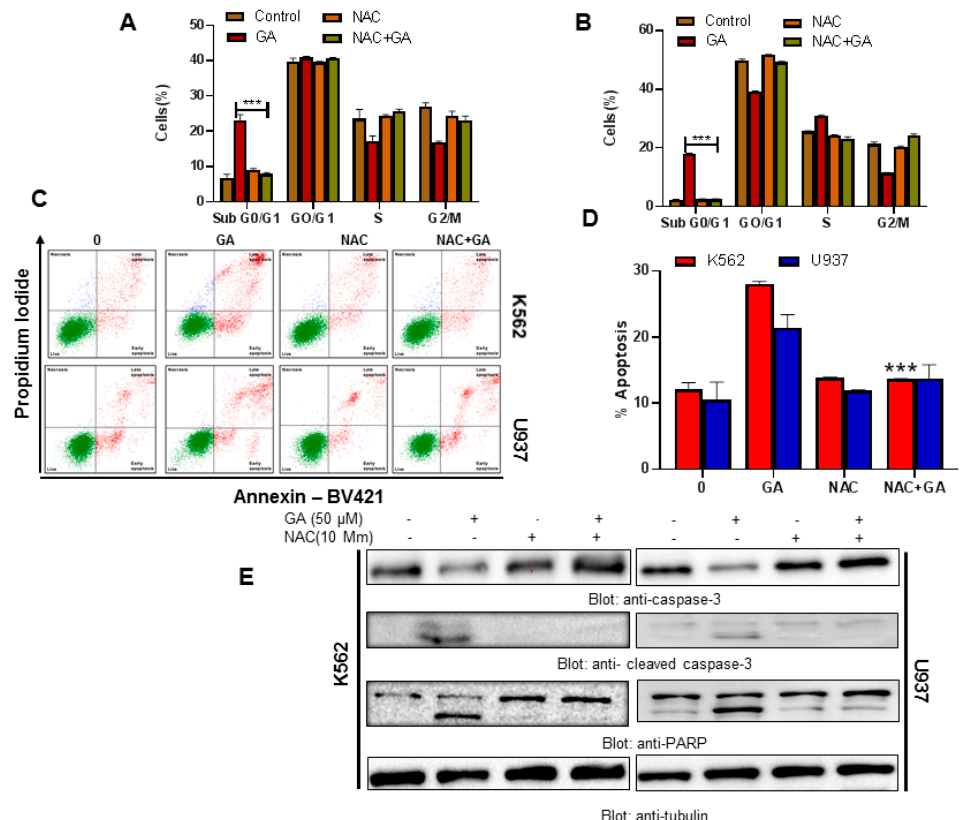
Figure 7. Greensporone A-mediated ROS generation involved in apoptotic cell death in leukemic cells. ( A,B ) N-acetyl cysteine (NAC) pre-treated leukemic cells abrogated the greensporone A-induced increase in SubG0 fraction in K562 and U937 cells. K562 and U937 cells were pretreated with 10 mM NAC followed by 50 µM GA for 24 h, and cell cycle fraction was measured by flow cytometry. ( C,D ) K562 and U937 cells were pretreated with 10 mM NAC followed by 50 µM GA for 24 h, and apoptosis was measured by staining with fluorescein-conjugated Annexin V and propidium iodide (PI) and analyzed by flow cytometry. The graph displays the mean +/-SD of three independent experiments (* P < 0.05, ** P < 0.01 and *** P < 0.001). NAC pre-treated leukemic cells prevented greensporone A-mediated activation of caspases. ( E ) K562 and U937 cells were pretreated with 10 mM NAC then subsequently treated with 50 µM GA as indicated for 24 h. Lysed cell extracts were separated on SDS-PAGE, transferred to PVDF membrane, and immunoblotted with an antibody against procaspase-3, cleaved caspase-3, PARP, and tubulin.